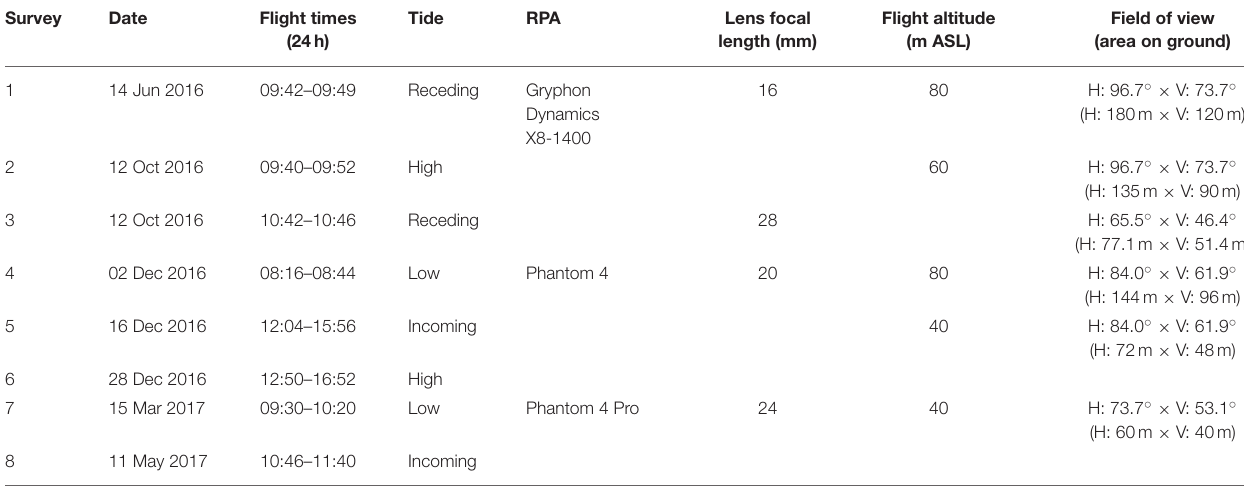
TABLE 2 | Details of system settings for RPA surveys.